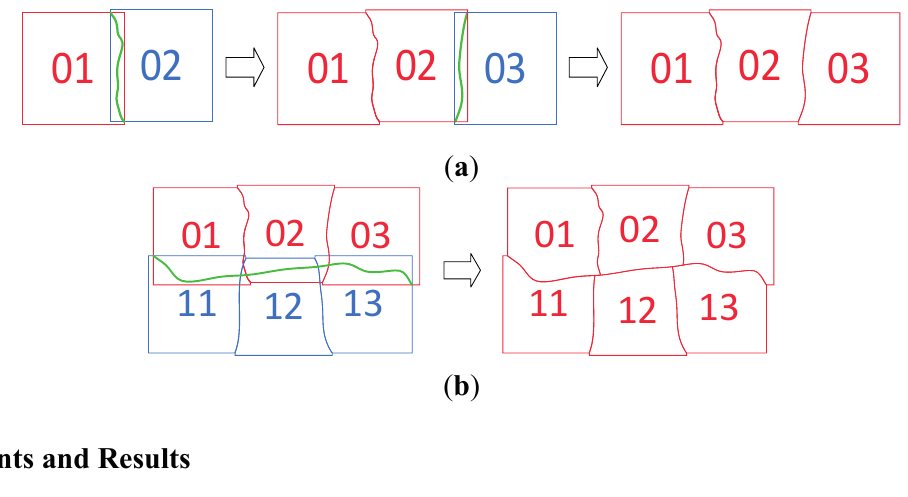
Figure 10. Construction of a seamline network. ( a ) Construction process for images in one strip; ( b ) construction process for adjacent strips. The red part represents the determined EMPs. The blue part represents the newly-added image. The green line represents the newly-selected seamline. 01, 02 and 03 represent the three images in the first strip, while 11, 12 and 13 represent the three images in the second